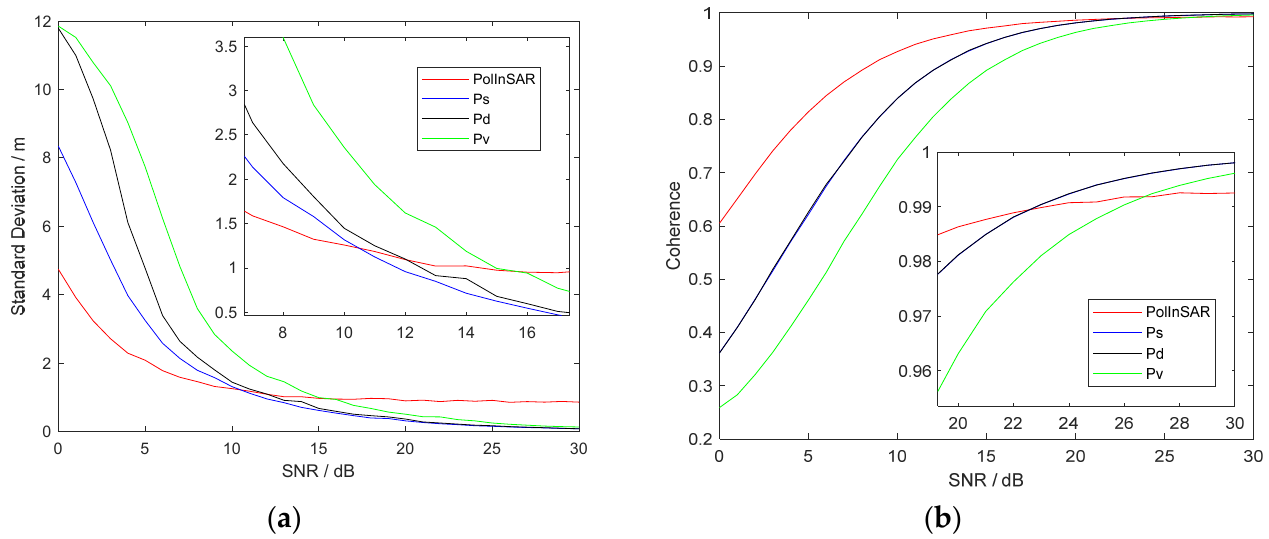
Figure 14. Simulation results of case 2.3 in artificial target area. ( a ) Standard deviation of height. ( b ) Coherence.